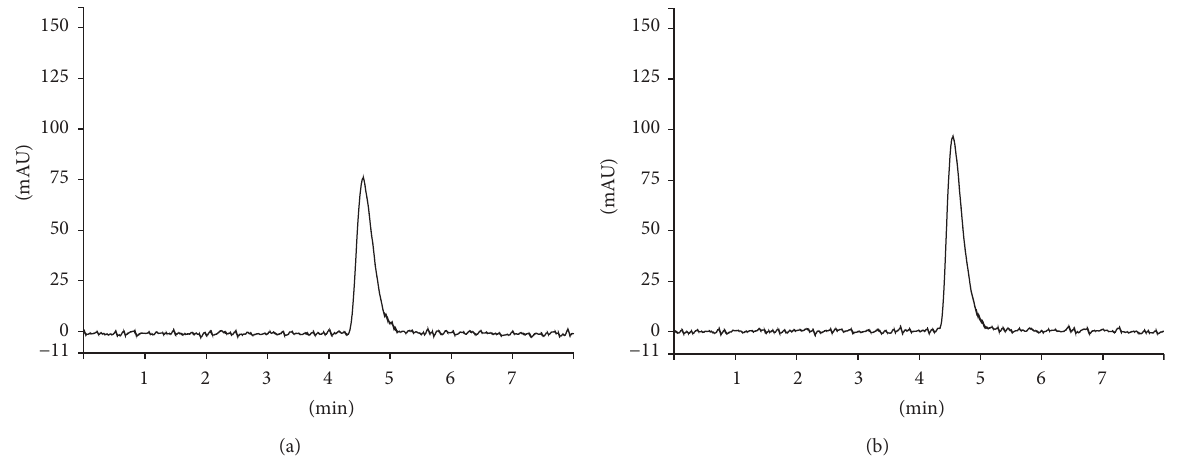
Figure 5: Chromatograms obtained after one hour of FA exposure under acid (a) and alkaline (b) conditions.